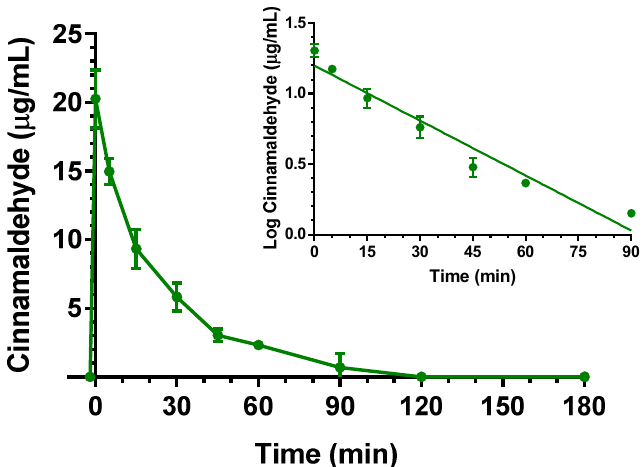
Figure 3. Elimination profile of cinnamaldehyde after 5 mg (20 mg/kg) intravenous infusion to rats. Data are expressed as the mean ± SE of four independent experiments. The elimination followed an apparent first order kinetics, confirmed by the semilogarithmic plot reported in the inset ( n = 7, r = 0.976, p < 0.001). The half-life of cinnamaldehyde was calculated to be 23.1 ± 1.6 min.